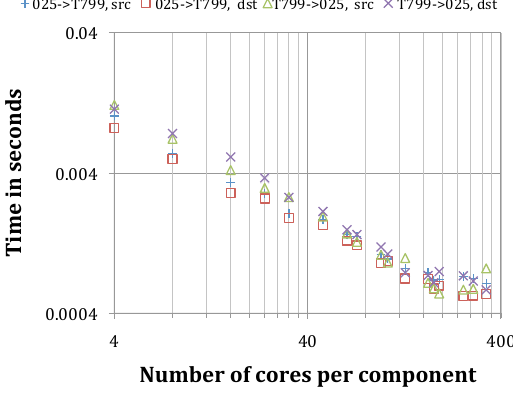
Figure 4. OASIS3-MCT_3.0 T799-ORCA025 mapping time ver- sus core count per component on Lenovo. src and dst mapping are shown for both mapping directions using the bfb algorithm based on tests where 1000 ping-pongs were